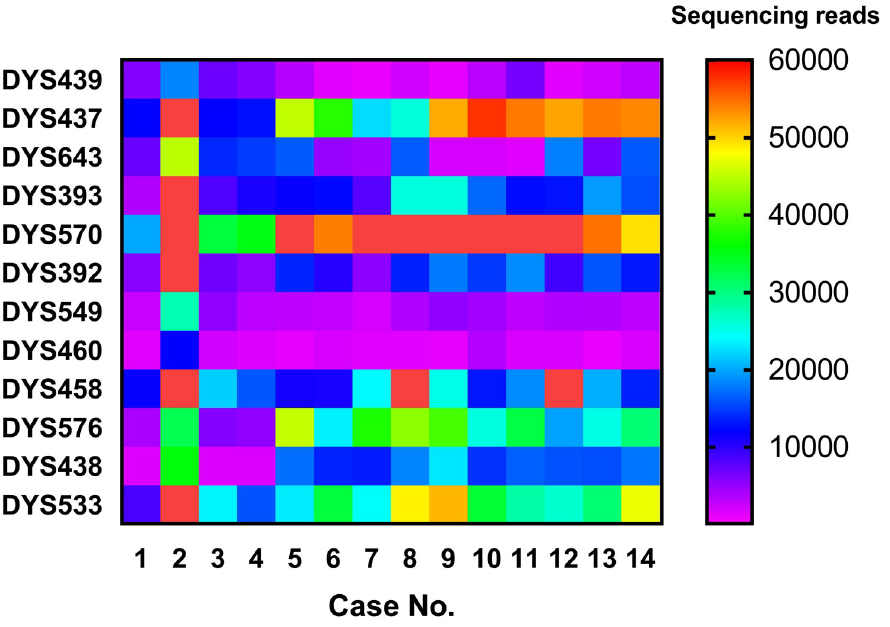
Fig 3. The NGS sequencing reads per sample per locus of plasma DNA (range: 1068–140045 reads).